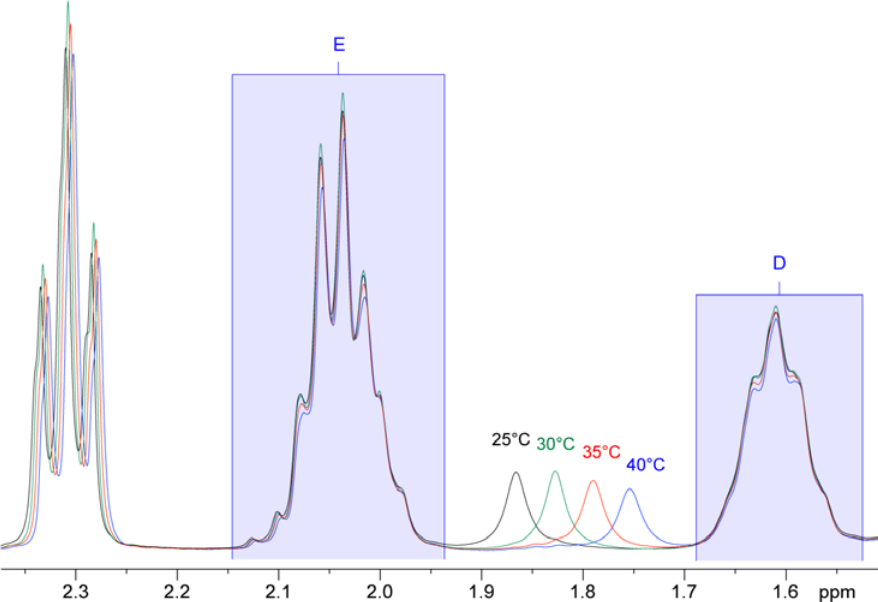
Figure 2. Temperature series of 300 MHz 1 H-NMR spectra of soy oil in CDCl 3 referenced to internal TMS. The spectra were acquired at 4 different temperatures and the results were overlaid to illustrate the dependence of the water signal chemical shift on the sample temperature.